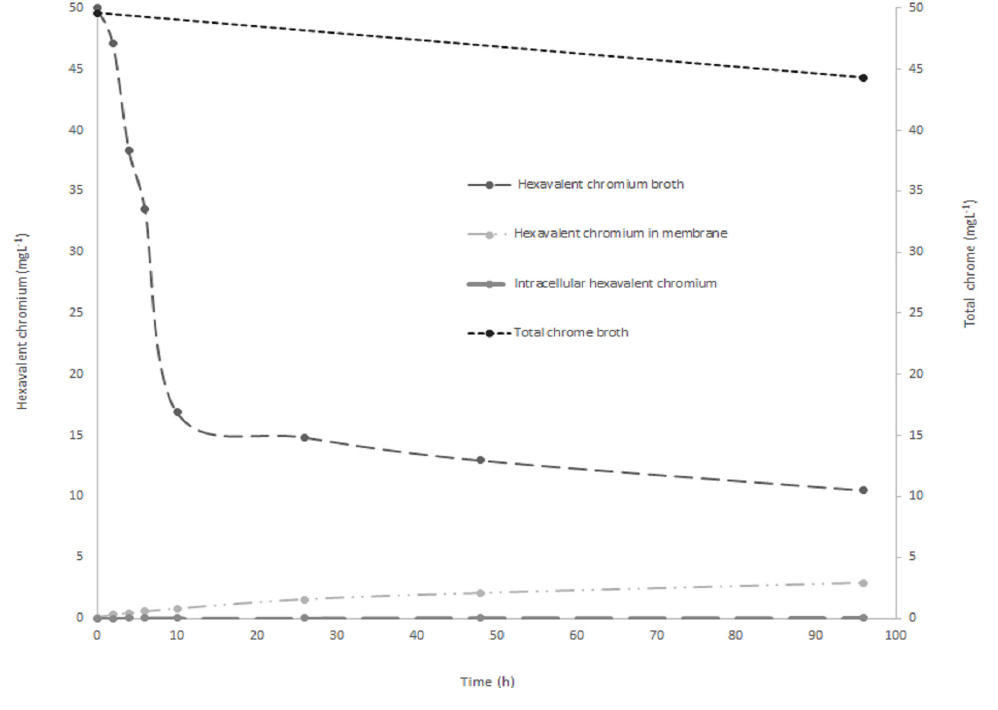
Kinetics of the reduction